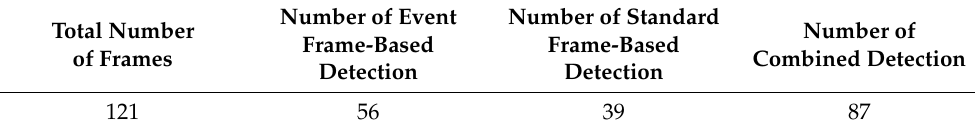
Table 3. Numbers of frames detected by different methods.